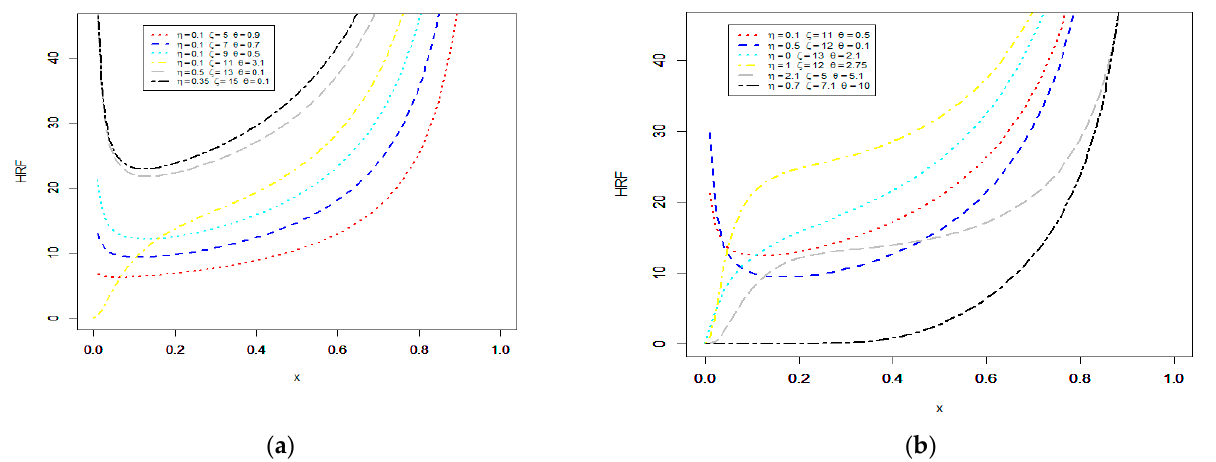
Figure 1. Plots of the probability density function (PDF) of the E-NPF model for different values of its parameters ( a , b ).